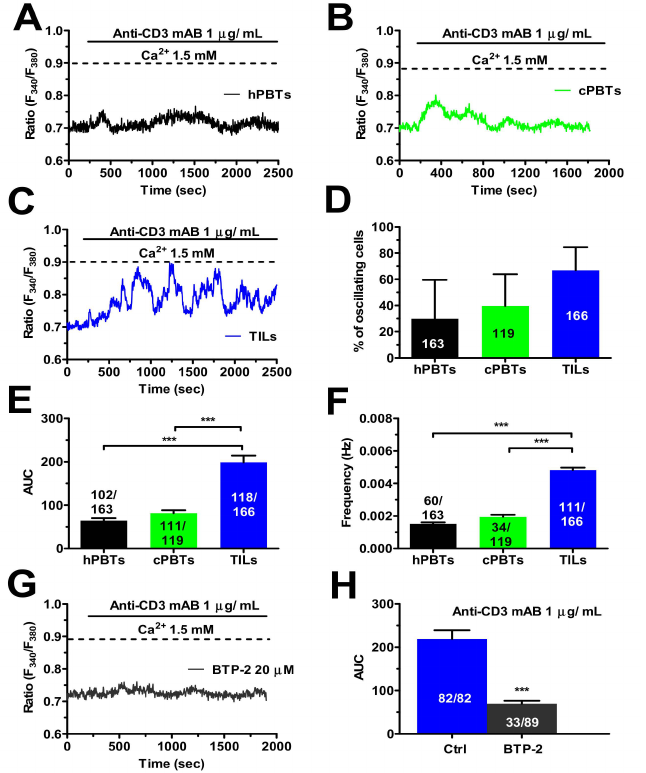
Figure 6. TCR stimulation by an anti-CD3 mAB evoked a stronger oscillatory Ca 2+ response in TILs than in hPBTs and cPBTs. ( A ) Intracellular Ca 2+ oscillations evoked in hPBTs by an anti-CD3 mAB (1 µ g/mL). ( B ) Intracellular Ca 2+ oscillations evoked in cPBTs by an anti-CD3 mAB (1 µ g/mL). ( C ) Intracellular Ca 2+ oscillations evoked in TILs by an anti-CD3 mAB (1 µ g/mL). ( D ) Mean ± SE of the percentage of hPBTs, cPBTs and TILs responding to the anti-CD3 mAB stimulation. ( E ) Mean ± SE of the AUC of the spiking Ca 2+ signal arising in the three cell types upon stimulation with the anti- CD3 mAB. One-way ANOVA followed by the post hoc Bonferroni test: *** p < 0.001. ( F ) Mean ± SE of oscillation frequency in the three cell types displaying the spiking Ca 2+ response (i.e., more than 1 Ca 2+ transient) to the anti-CD3 mAB. One-way ANOVA followed by the post hoc Bonferroni test: *** p < 0.001. ( G ) Pre-treating TILs with BTP-2 (20 µ m, 20 min), which selectively inhibits SOCE by blocking extracellular Ca 2+ influx through Orai1, dampens the intracellular Ca 2+ oscillations evoked by the anti-CD3 mAB (1 µ g/mL). ( H ) Mean ± SE of the AUC of the spiking Ca 2+ signal arising in TILs challenged with the anti-CD3 mAB in the absence (Ctrl) and presence of BTP-2. Student’s t -test: *** p < 0.001. In panels ( B , D , F , H ), the numbers within or above the histogram bars indicate the number of responding cells over the total number of analysed